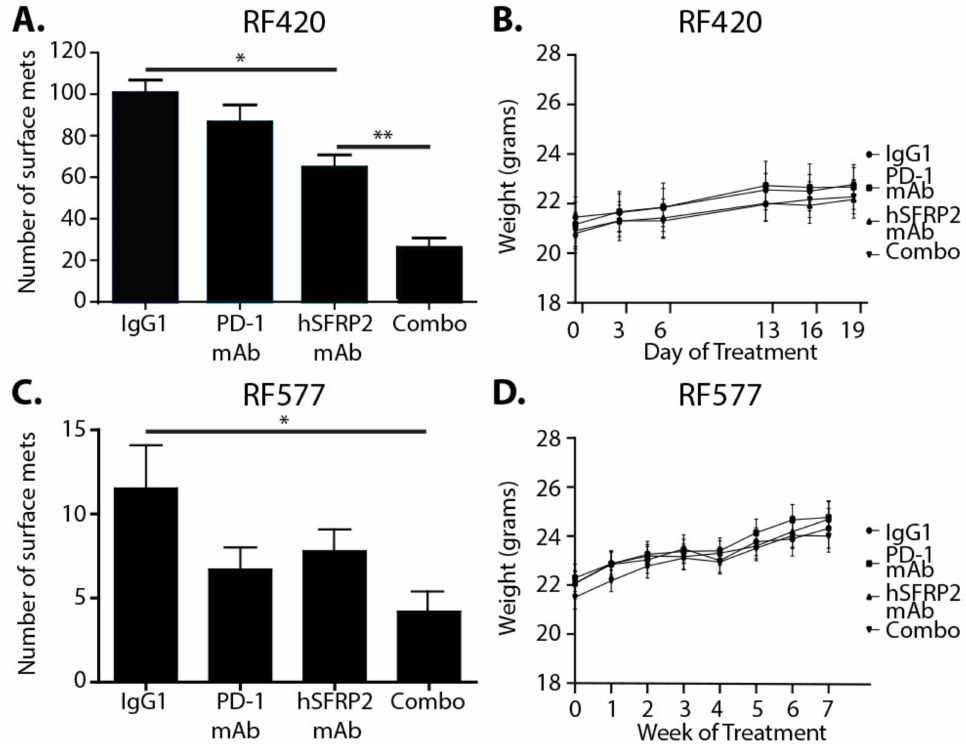
Figure 2. hSFRP2 mAb is additive to mPD-1 mAb in reducing metastatic osteosarcoma growth in vivo. Two models of OS lung metastases using RF420 or RF577 cell lines were generated by tail vein injection in C57BL/6 mice. ( A , B ) For